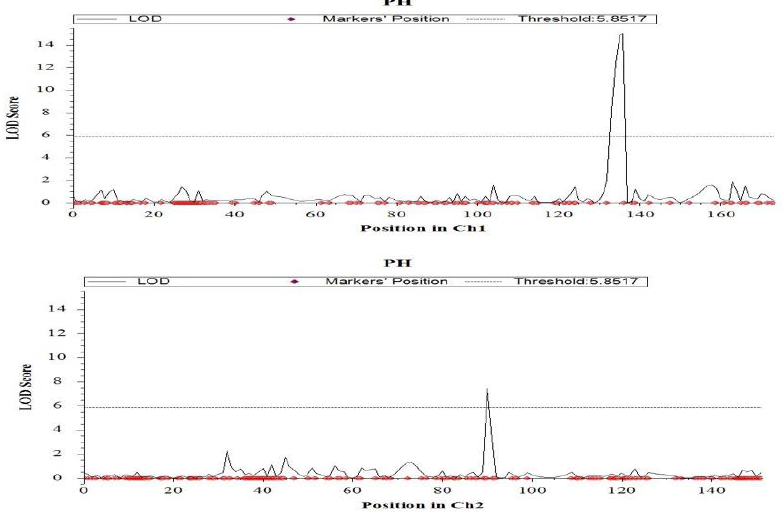
Figure 5. Chromosome locations of QTLs for plant height under salinity stress based on a significant threshold of LOD 3.0 using ICIMapping. The horizontal line indicates the significant LOD threshold at 95% confidence levels based on 1000 permutations.